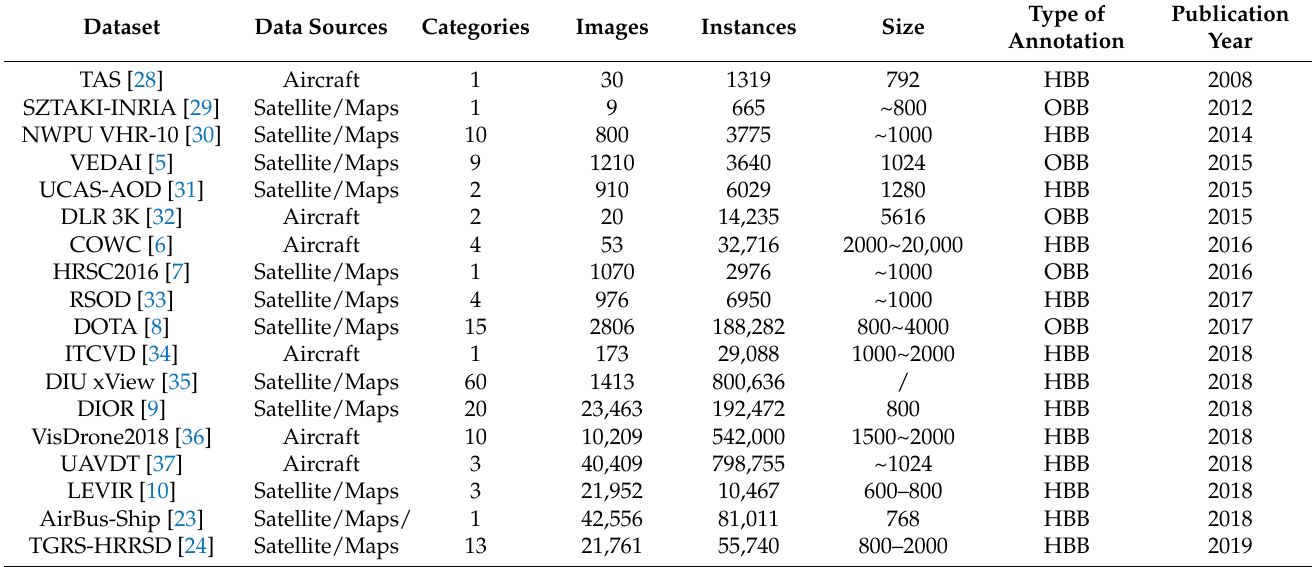
Table 1. Existing publicly available aerial image datasets. HBB indicates horizontal bounding box and OBB indicates oriented bounding